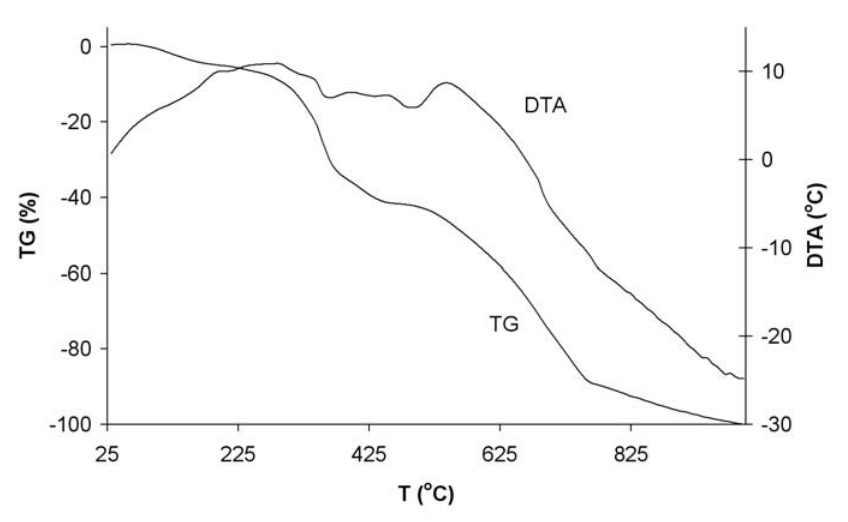
Fig. 4 Thermal decomposition (TG and DTA) curves of the Cu-tren